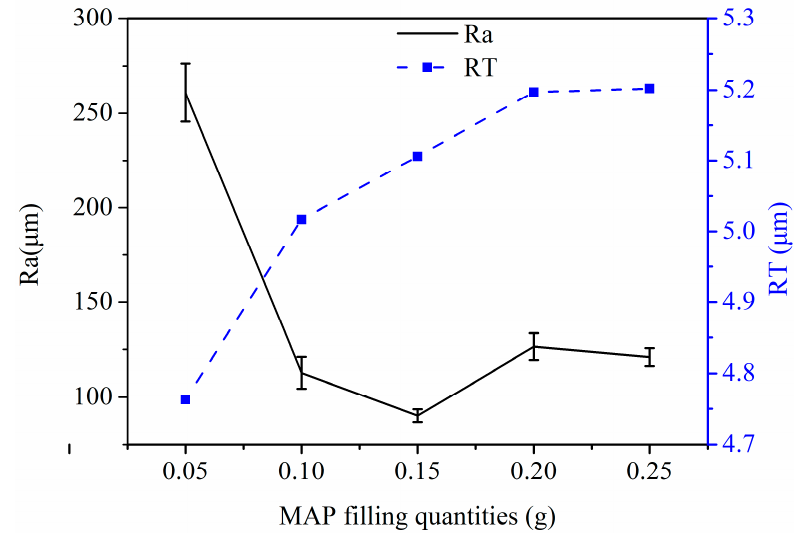
Figure 10. Graph of the effect of MAP filling quantities on Ra and RT values of tube inner wall.